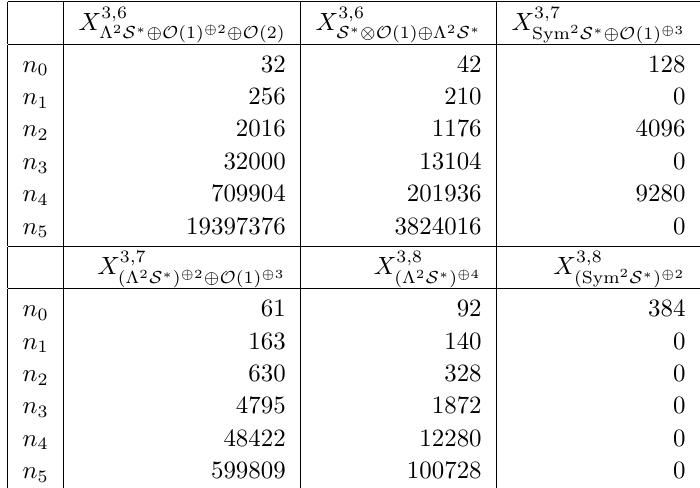
Table 4 . The triple intersection number and instanton numbers for CY 3-folds in Gr(3 ; m ).